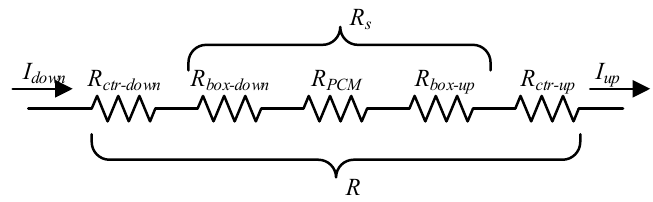
Figure 3. Schematic diagram of steady-state thermal resistance series structure.